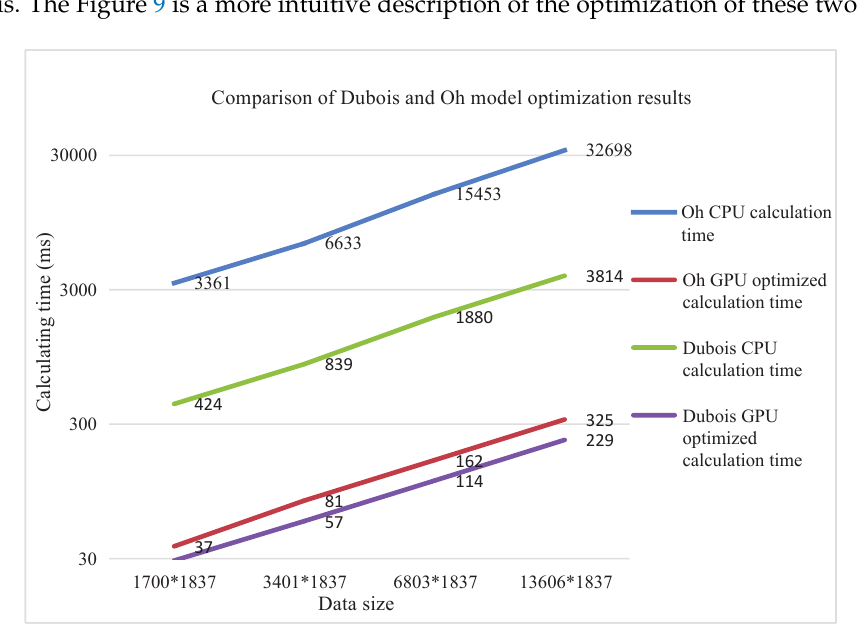
Figure 9. Comparison of the Dubois and Oh algorithm optimization